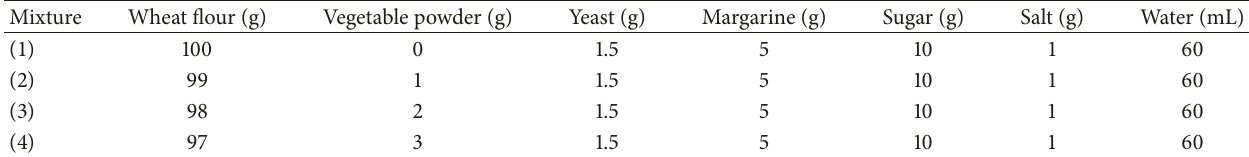
Table 1: Formulation of wheat-vegetable